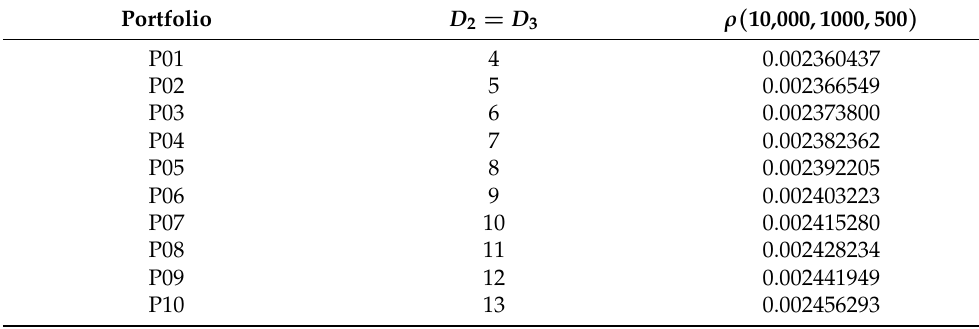
Table 8. Cases 2.3—Impact of the lifetime distributions on the risk index.